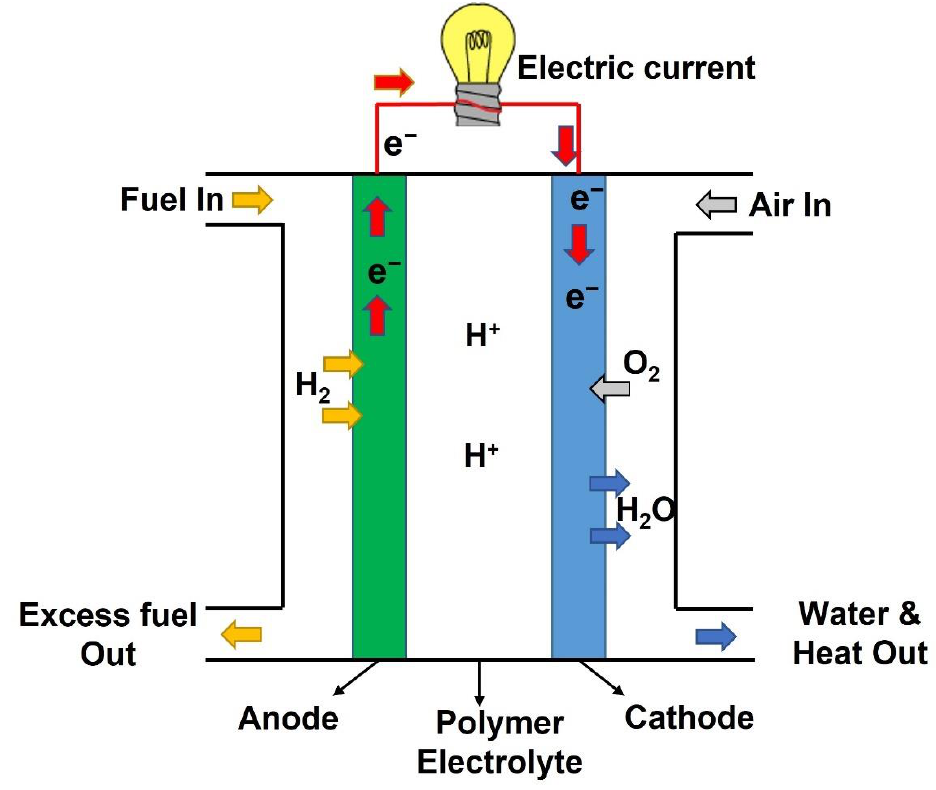
Figure 1. Basic schematic diagram of a PEMFC.